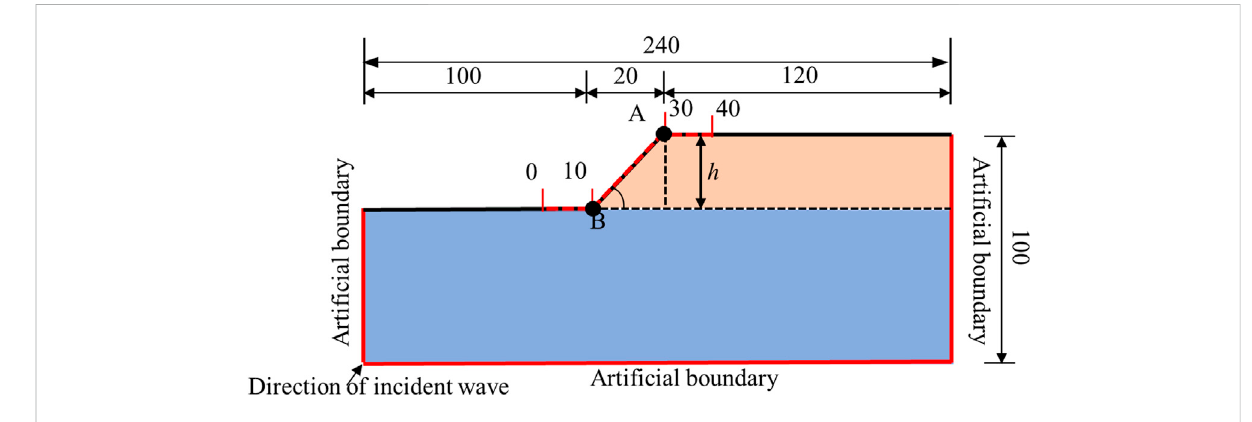
FIGURE 3 Calculation model for the layered slope site exposed to obliquely incident P waves.